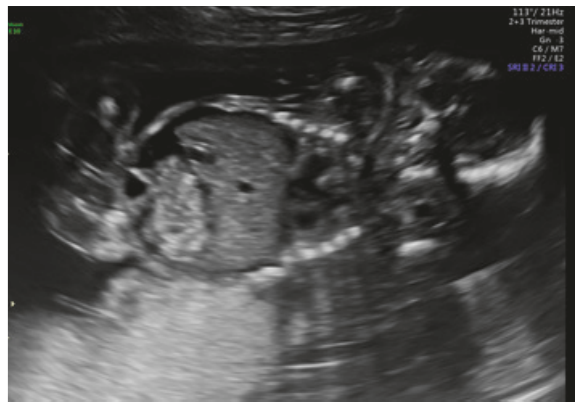
Figure 1: Nuchal translucency 3.2 mm.